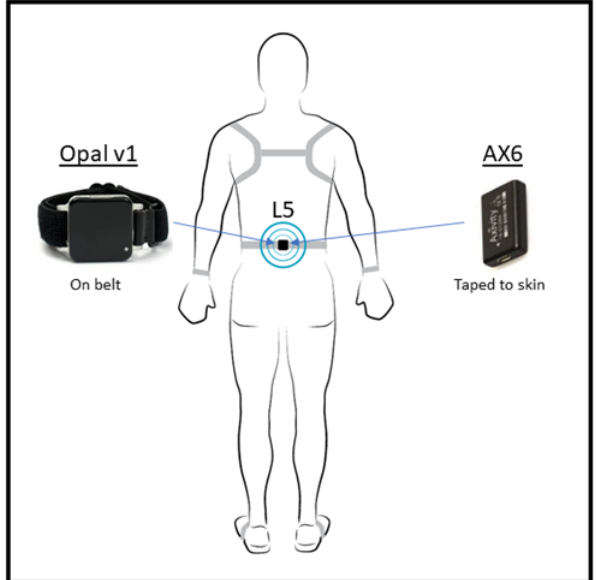
Figure 1. Participant set-up.